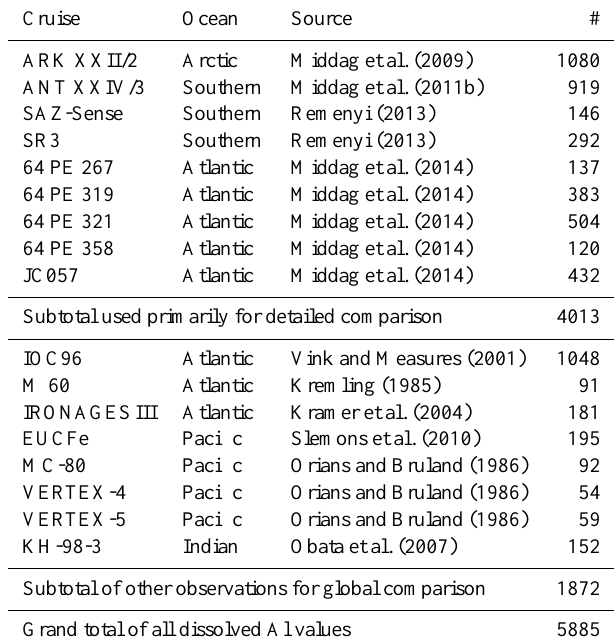
Table 4. Observational data used for comparison with